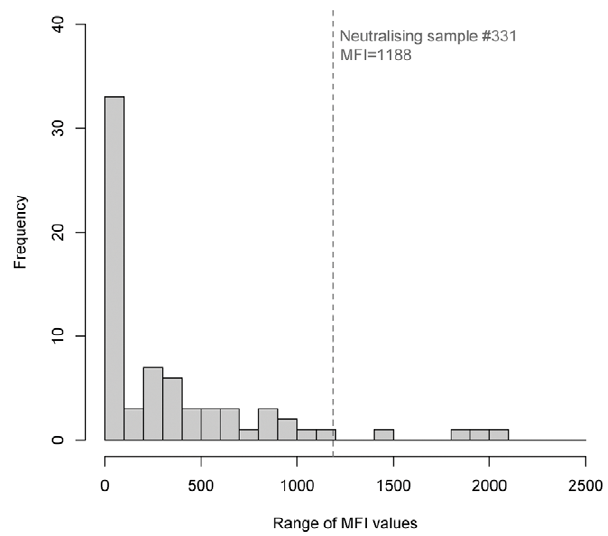
Figure 4. Frequency distribution of Luminex Median Fluores- cent Intensity (MFI) values against NiV in Eidolon helvum annobonensis . The dotted line represents the where the MFI of the neutralising sample (Bat # 331) lies within this distribution.